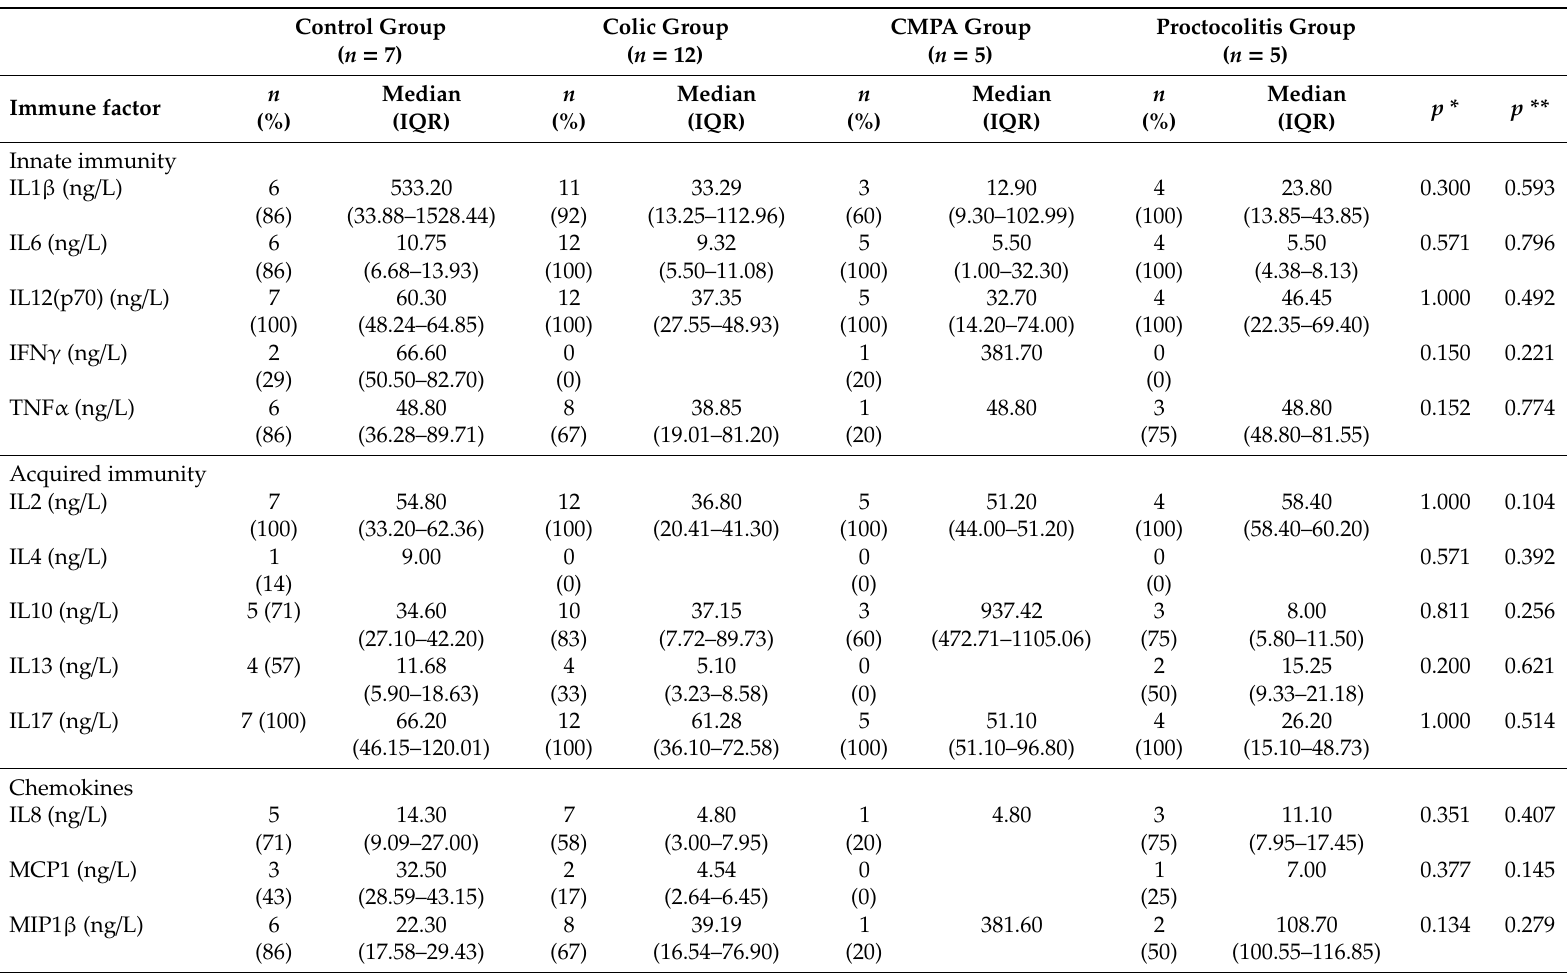
Table 4. Frequency and concentration of immune factors in fecal samples ( N = 28) from participants in each group of study: control, colic, cow’s milk protein allergy (CMPA), and